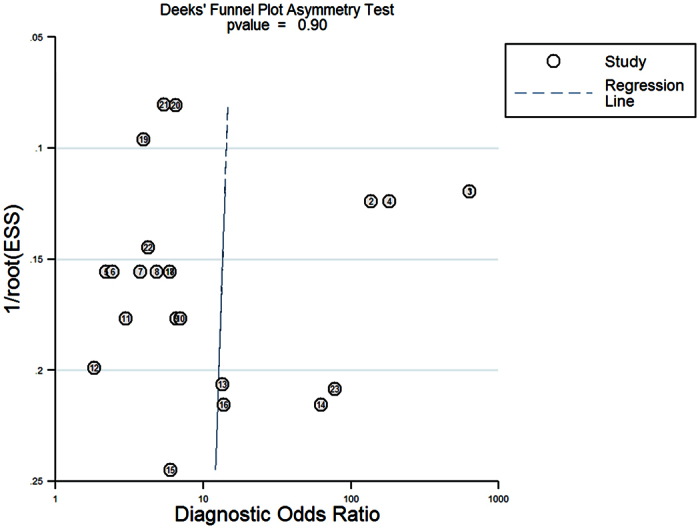
Deeks’ funnel plot.